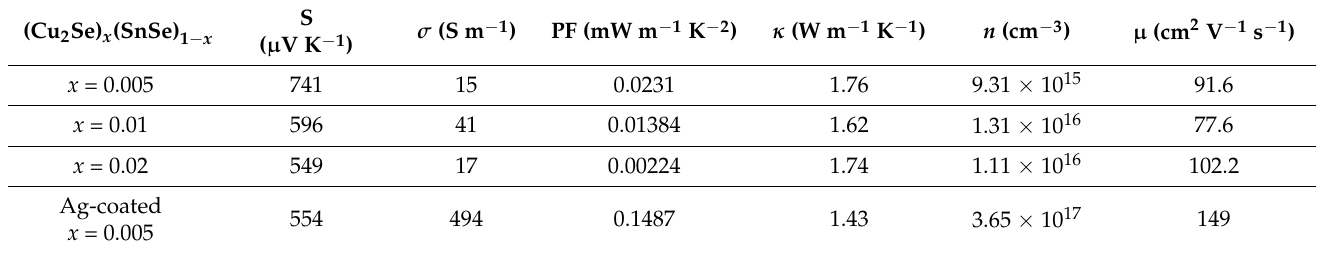
Table 1. Measured properties of (Cu 2 Se) x (SnSe) 1 − x and Ag-doped alloy at 303